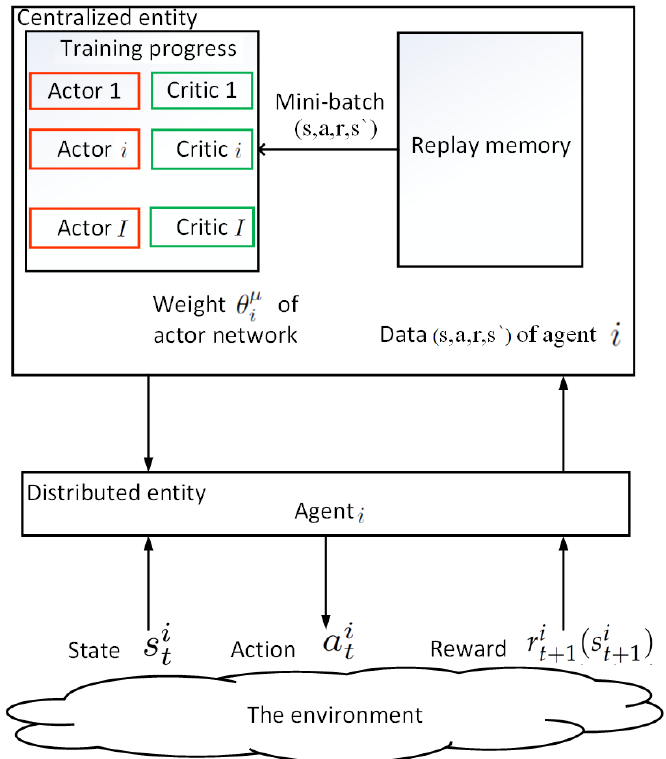
Figure 4. The centralized entity gathers experiences from agents 1 . . . i . . . I , stores them in its replay memory, and performs training. Shown in the figure is one of the distributed agents, namely, agent i , that performs action